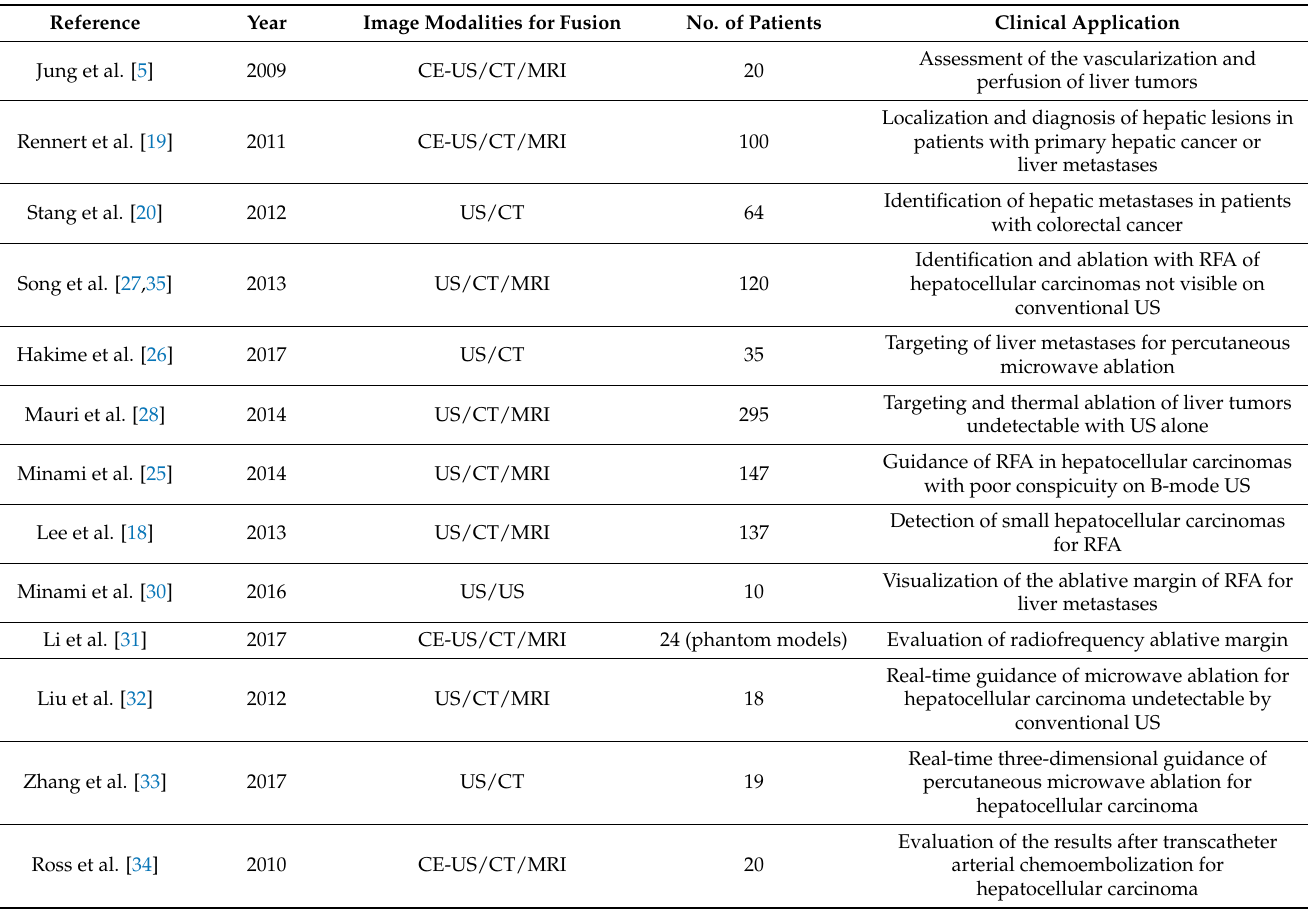
Table 1. Overview of the clinical applications of image fusion for liver